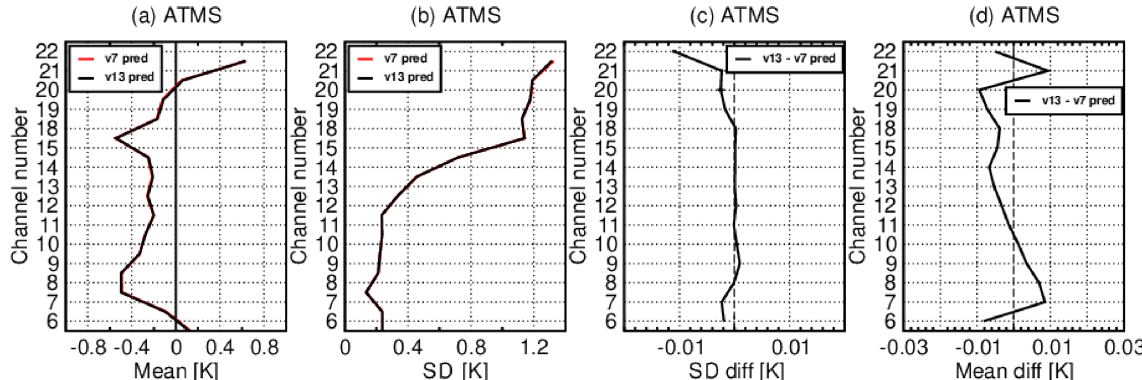
Figure 12. Global statistics of observation minus background (O − B) departure before variational bias correction for ATMS on S- NPP/NOAA-20 during 1–31 March 2020 in the ECMWF system: (a) mean (O − B); (b) standard deviation of (O − B); (c) difference of the standard deviations; (d) difference of the absolute means; ATMS statistics for the v13 predictor experiment are shown in black, whereas statistics for the v7 predictor experiment are shown in red.